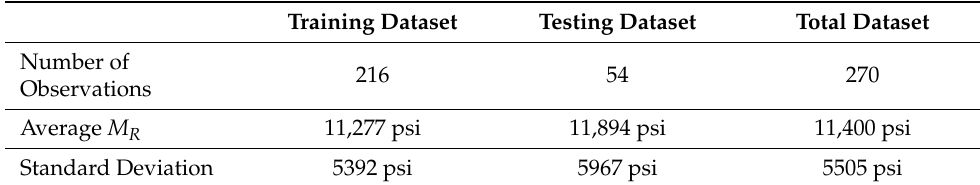
Table 3. Summary of statistics for M R